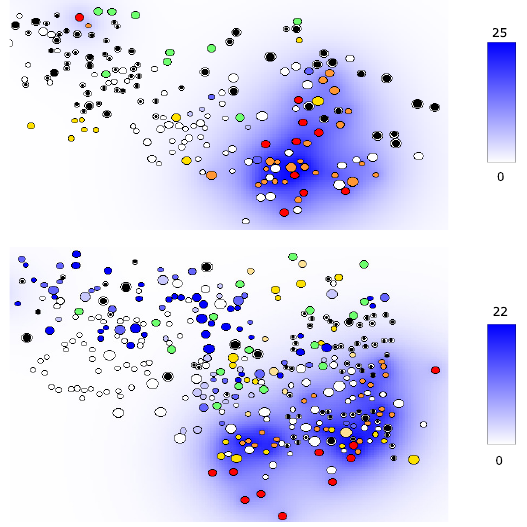
Figure 7. Snapshots of the simulation in which the concentration of HIV (in virions/ µ L) is shown in blue color gradient. Different cell types are represented as follows: uninfected APCs (green), infected APCs (red), naive uninfected CD4 + T cells (black), infected CD4 + T cells (orange), naive CD8 + T cells (white), three maturity levels of differentiated CD8 + T cells (blue) and two maturity levels of uninfected CD4 + T cells (yellow). ( top ) Three days after the virus transmission; ( bottom ) 12 days after virus